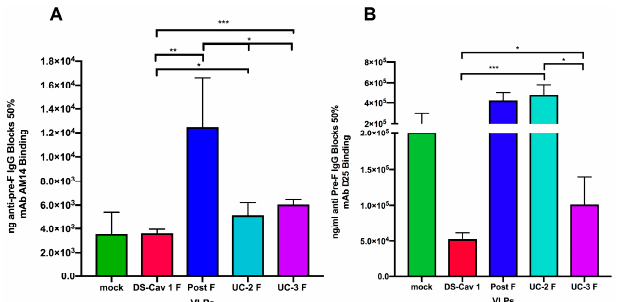
Figure 1. Blocking of binding of pre-fusion specific monoclonal antibodies (mAb) by sera from virus-like particle (VLP)-immunized dams. Shown are the concentrations (ng / mL) of total anti-pre-fusion F binding IgG that blocked 50% binding of mAb AM14 (panel A) or D25 (panel B) to soluble pre-fusion F protein (DS-Cav1) target in ELISA. Five groups of RSV primed, and pregnant CR dams were immunized with 100 µ g of four di ff erent VLPs (DS-Cav1 F, Post F, UC-2 F, or UC-3 F VLPs) or mock at 2 weeks of gestation. Sera were harvested from each group at 4 weeks of gestation, just before the delivery of pups. Sera from each group were pooled, and the ng / mL of anti-pre-F binding IgG that blocked 50% of the binding of the mAb was determined as described previously [18] and in the Materials and Methods. Values above 4–5 × 10 5 ng / mL in VLP sera indicate minimal or no blocking of the mAb. The results are the mean of three to five separate determinations with standard deviations indicated. *** p < 0.0005; ** p < 0.005; * p < 0.05.